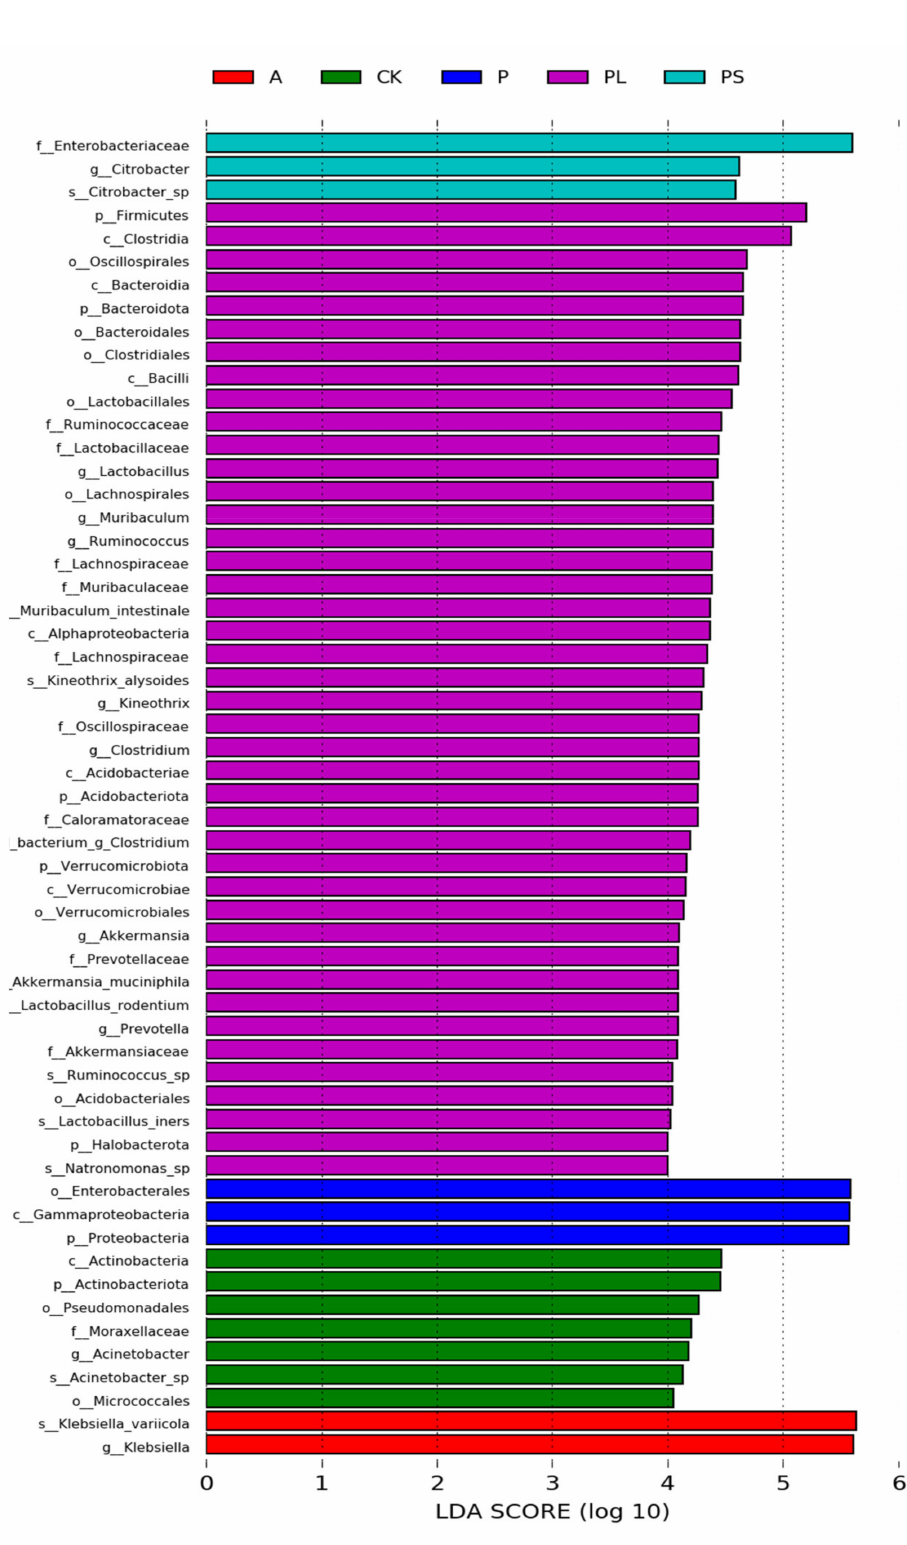
Figure 6. Bacterial taxa with linear discriminant analysis (LDA) score greater than four in the gut microbiota of G. molesta feeding on different host